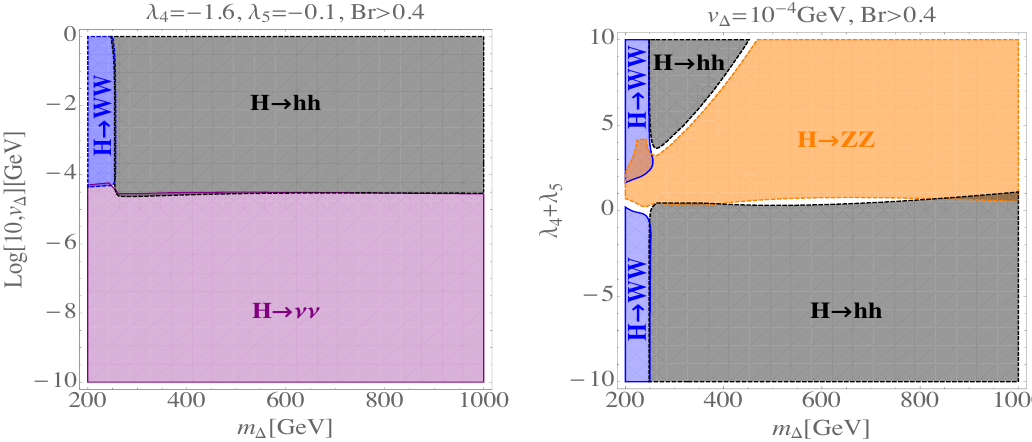
Figure 12 . Decay region plots for H with BR (cid:21) 40%. Black region for the di-Higgs channel, blue region for the di-W boson channel and purple region for the di-neutrino channel. From the left panel, di-neutrino/di- h channel dominates at small/large v (cid:1) respectively, and W -pair channel dominates at the large v (cid:1) and small m (cid:1) region. While from the right panel, we observe that di- h (di- Z boson) channel dominates for negative (positive) (cid:21) 45 .